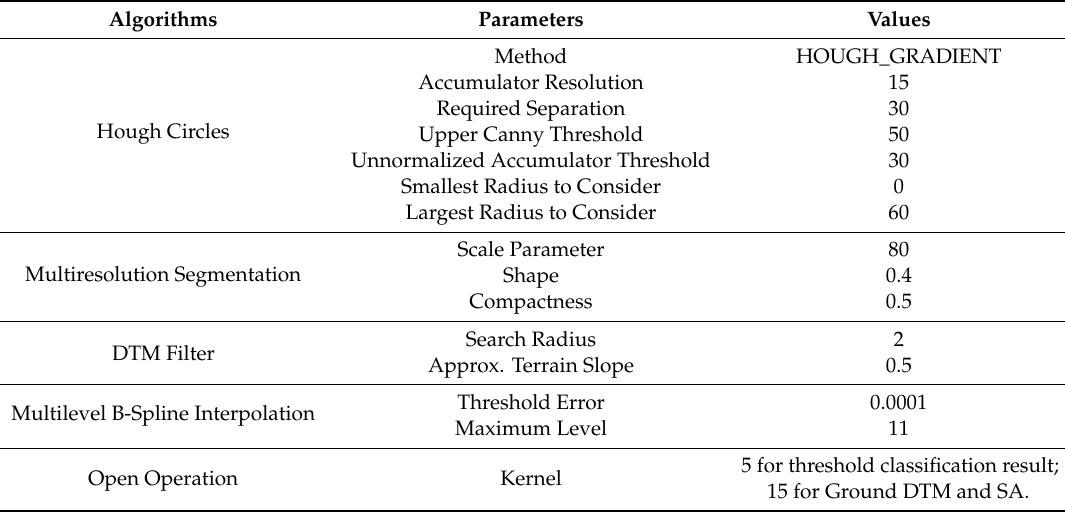
Table 3. The parameter settings of the main algorithms used in this